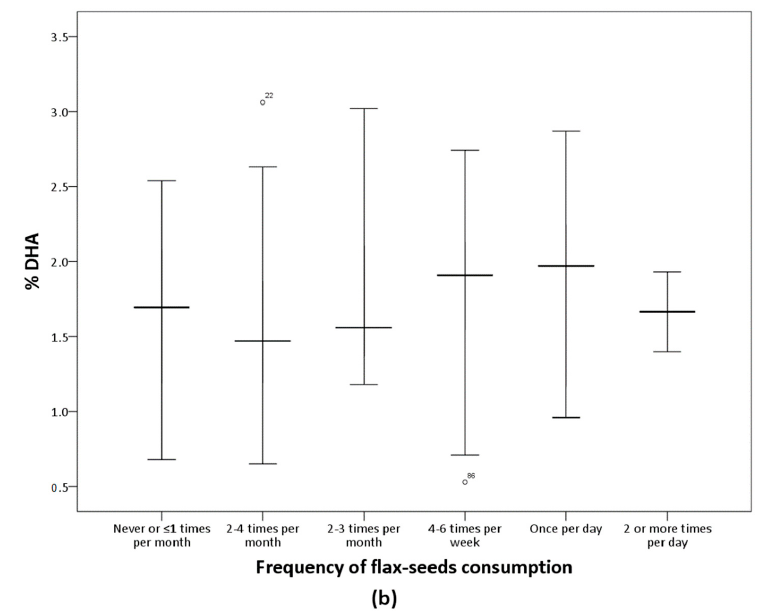
Figure 1. Percentage of ALA and DHA according to flax-seeds frequency of consumption. Median values and interquartile ranges are presented. ( a ) Significant differences among groups by Kruskal-Wallis ( p = 0.001). ( b ) The differences among groups were not significant ( p = 0.145).